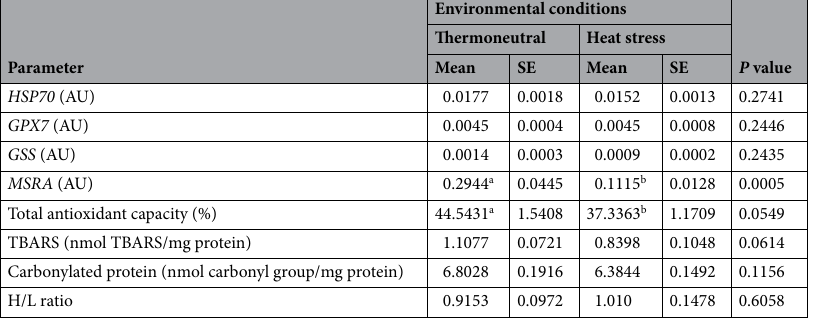
Table 2. Effect of ambient temperature on the expression of heat-shock protein 70 kDa ( HSP70 ), glutathione peroxidase 7 ( GPX7 ), glutathione synthetase ( GSS ), and methionine sulfoxide reductase A ( MSRA ) genes, total antioxidant capacity, lipid peroxidation (TBARS), carbonylated protein, and heterophil/lymphocyte (H/L) ratio in the liver of the mothers. Female quail hens were raised in a thermoneutral environment (23 °C and 60% relative humidity) ( n = 6) or subjected to heat stress (continuous exposure to 32 °C and 60% relative humidity) ( n = 6). The 2 −∆CT method was used for relative quantification of gene expression, and results are expressed as arbitrary units (AU), which represent the expression of each gene normalized to the expression of β-actin mRNA. The results are presented as mean and standard error (SE). a,b Different superscript letters in the same row indicate a significant difference by the t test ( P <